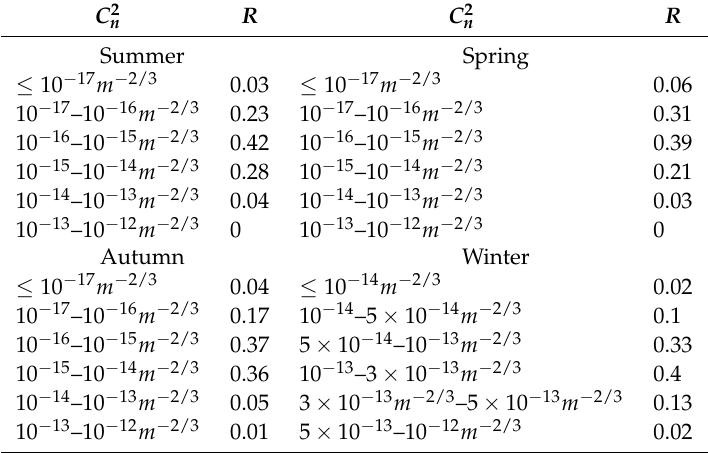
Table 1. The repeatability R of the optical turbulence at the Baykal astrophysical observatory site in different seasons. C 2 n R C 2 n